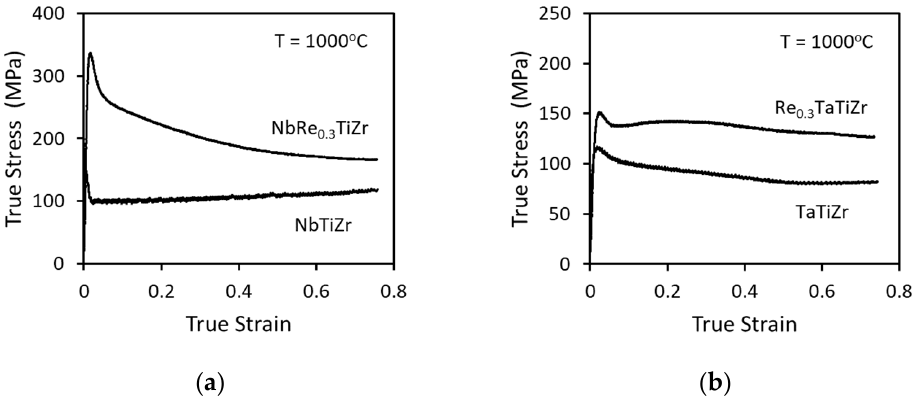
Figure 2. True stress versus true strain deformation curves for ( a ) NbTiZr and Re 0.3 NbTiZr and ( b ) TaTiZr and Re 0.3 TaTiZr acquired at 1000 °C.